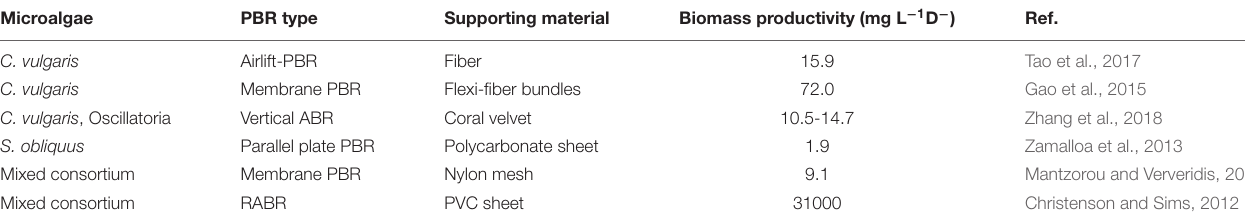
TABLE 4 | Microalgae biofilm system using different carrier material.